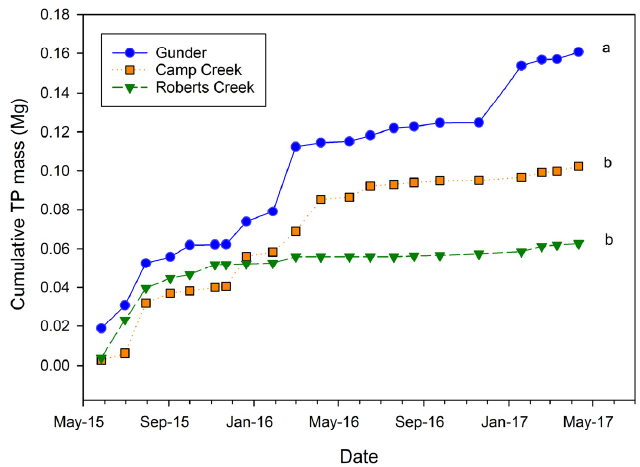
Figure 11. Cumulative mean TP mass loss for Camp Creek, Roberts Creek, and Gunder alluvial units, for the main stem of Walnut Creek, Iowa. Significant differences ( p value < 0.1) indicated by differing lower-case letters. Error bars omitted for clarity.